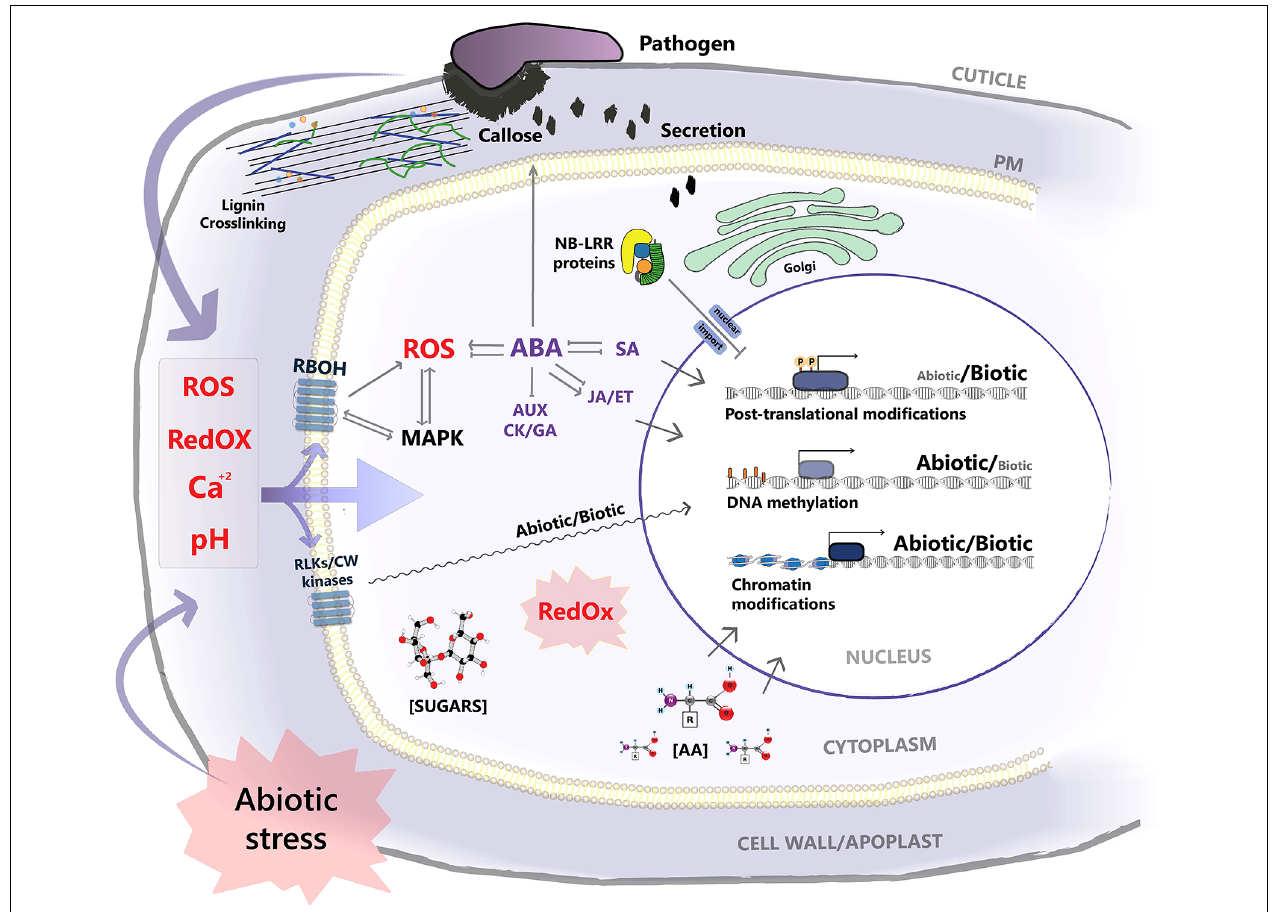
responses. ABA positively contributes to pre-invasion defense, enhancing callose deposition. Rewiring of secretory machinery under abiotic stress potentially affects its function in the exocytosis of antimicrobial compounds at the site of infection. Nuclear translocation of R-genes is negatively affected under abiotic stress. Redox state, as well as metabolite concentration such as sugars and amino acids (AA), function as drivers for post-translational modifications, modulating the activity of target proteins/transcription factors. Previously/simultaneously encountered stress effect on chromatin and DNA methylation status, potentially impacts on expression patterns of the recipient genes under stress combination. Transcription factor activation and binding to stress responsive gene promoters is a convergence point regulating the signal output under combinatorial stress with diverse